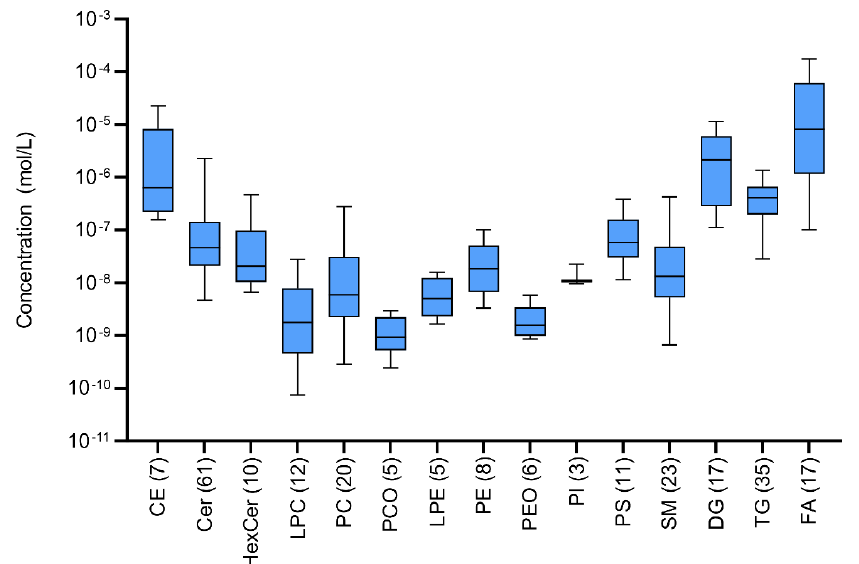
Figure 10. Boxplots of sweat extract concentration levels for quantified lipids in classes after the application of lnPQN transformation. Numbers in parentheses represent the number of identified lipids in each class.